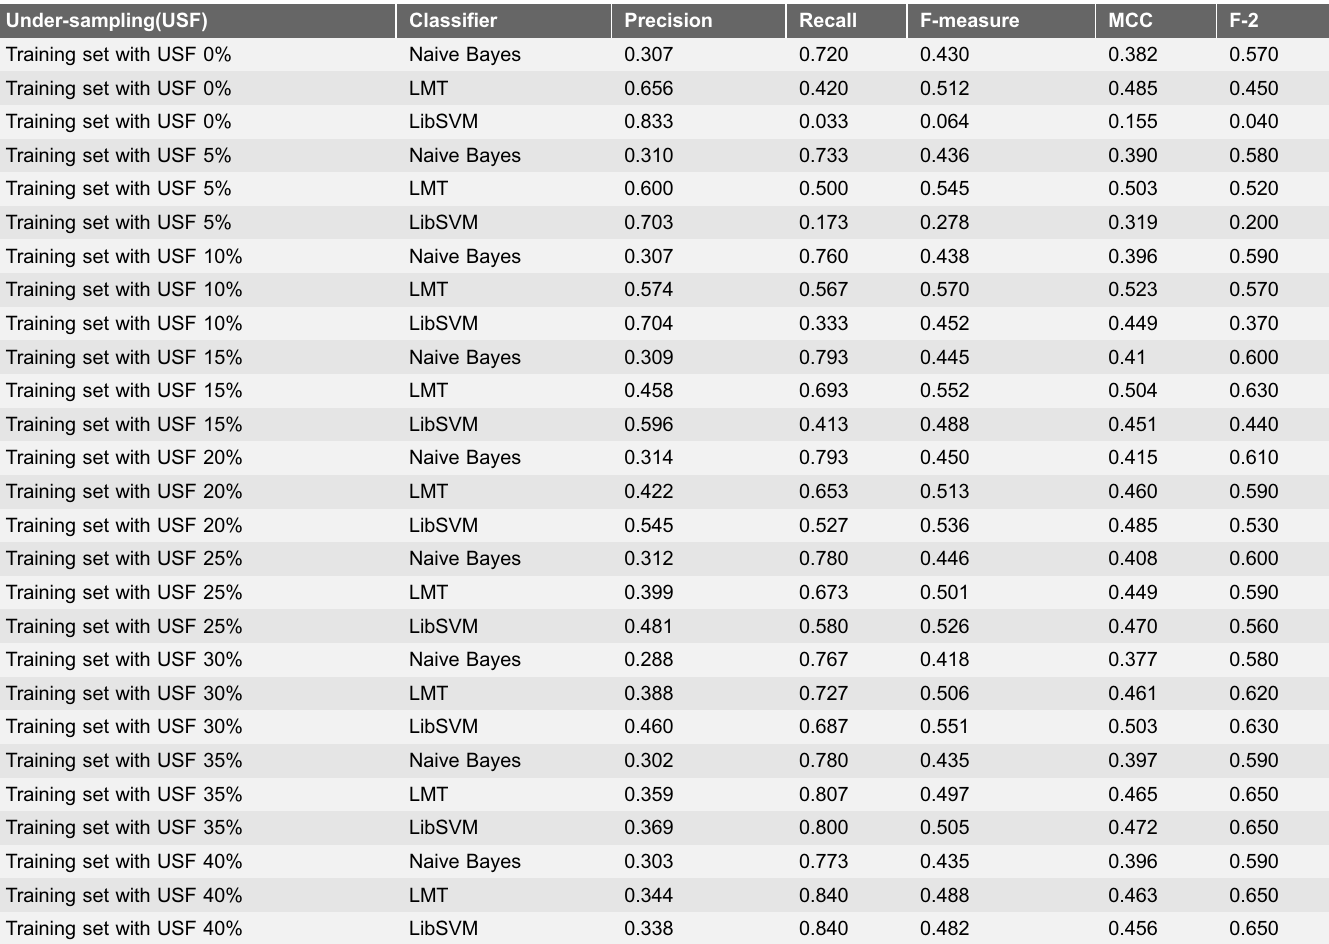
Table 7. mycoSORT Results - Set of Features